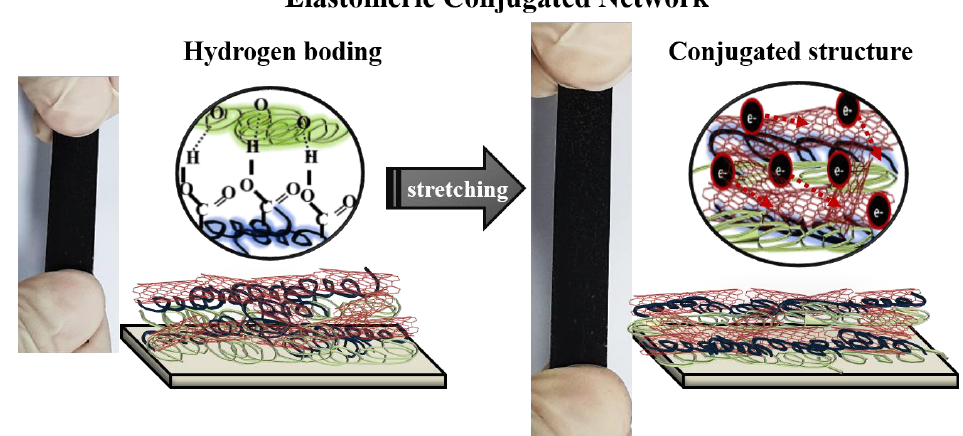
Figure 7. Schematic of the elastomeric conjugated network in PEO/DWNT-PAA nanocomposite thin films.